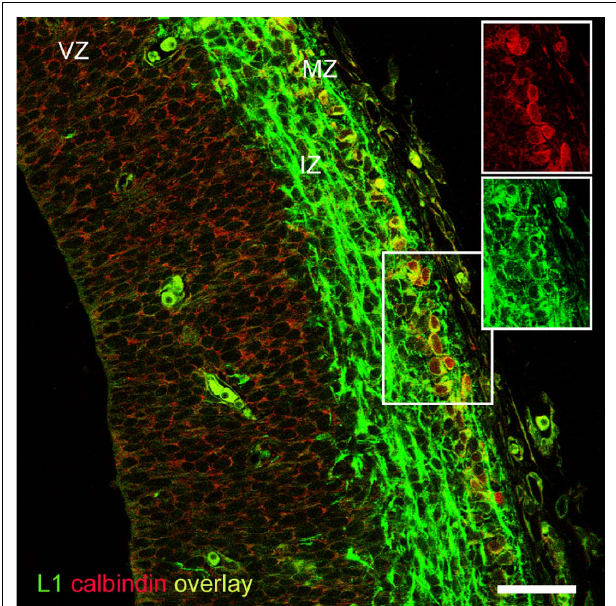
FIGURE 7 | CB + pioneer cells in the rat preplate co-expressed L1. Note the axonal projection of L1 + cells along the intermediate zone. Although adequate to revealing CB + cell bodies, Zenon immunostaining was not sensitive enough to detect CB + axons. Boxes show the separation of the fl uorescence channels. Rat E15.5. Single confocal section. IZ, intermediate zone; MZ, marginal zone; VZ, ventricular zone. C alibration bar: 50 µm.